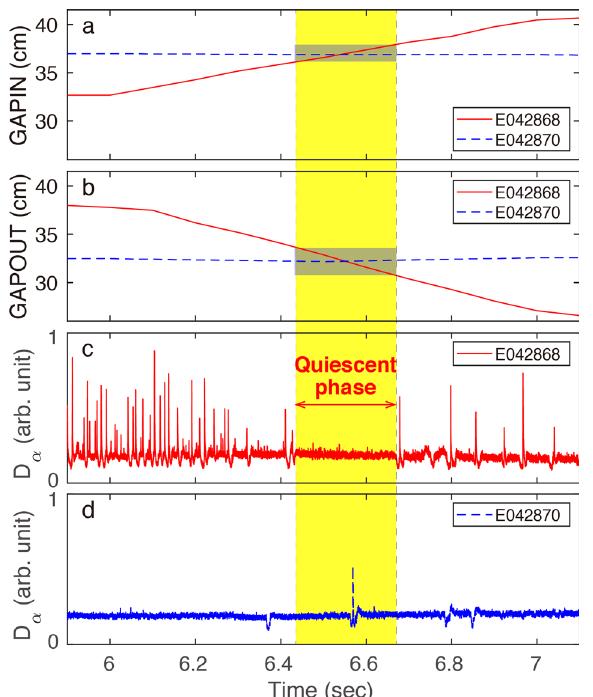
Fig. 3 Pedestal structures during the transition from the ELMy (high- con fi nement mode with edge-localized mode) to QH (quiescent high- con fi nement mode) phase in E042868. a Electron density, b electron temperature, c toroidal fl ow, and d radial electric fi eld. The ELMy and QH- phases are evaluated at t = 6.0 s (blue dashed line) and 6.5 s (solid red line), respectively. When fi tting the tanh-like functions to the data, the period of the time-averaging was approximated as ±100